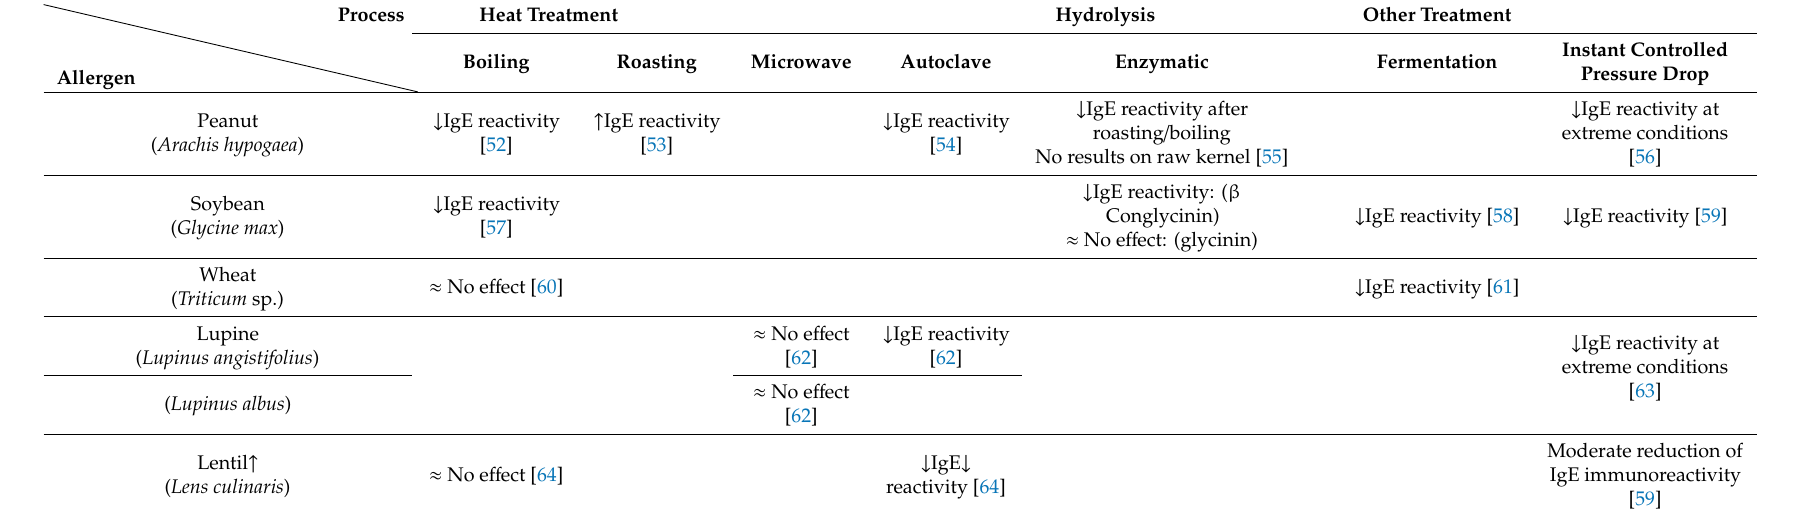
Table 2. Impact of food processing on some plant food allergenicity as assessed by IgE